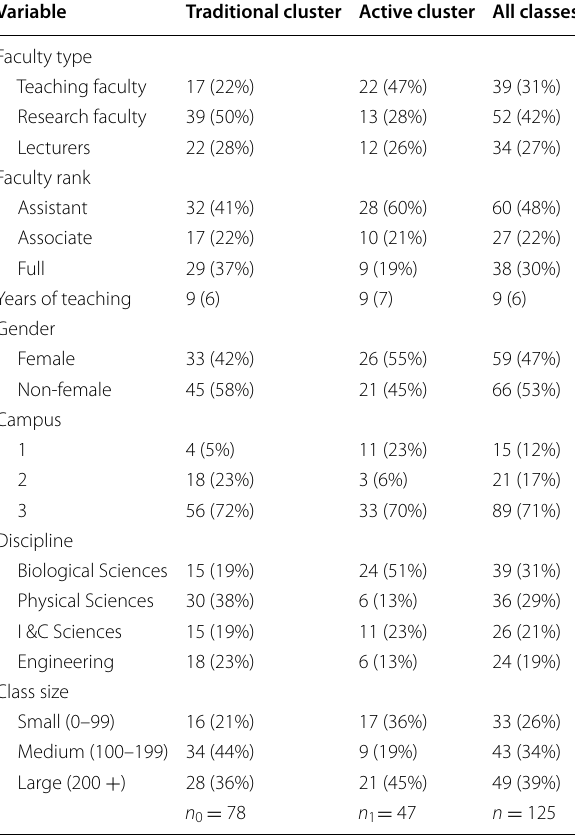
Table 4 Summary statistics for the final clustering